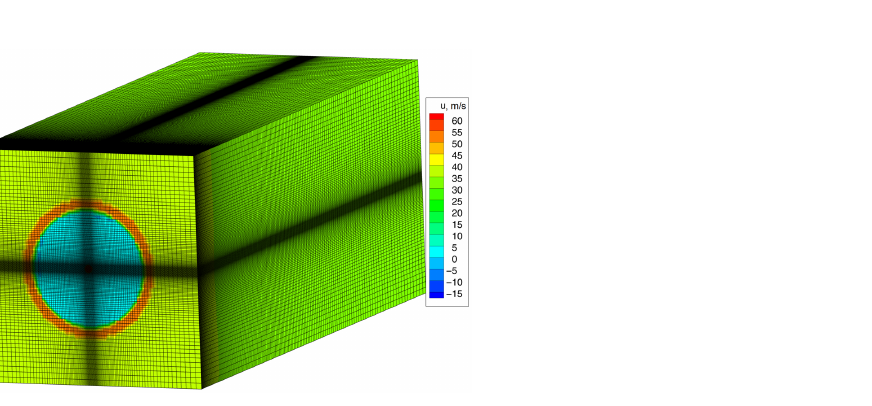
Figure 4. Computational domain with a grid and the initial distribution of the axial velocity field.